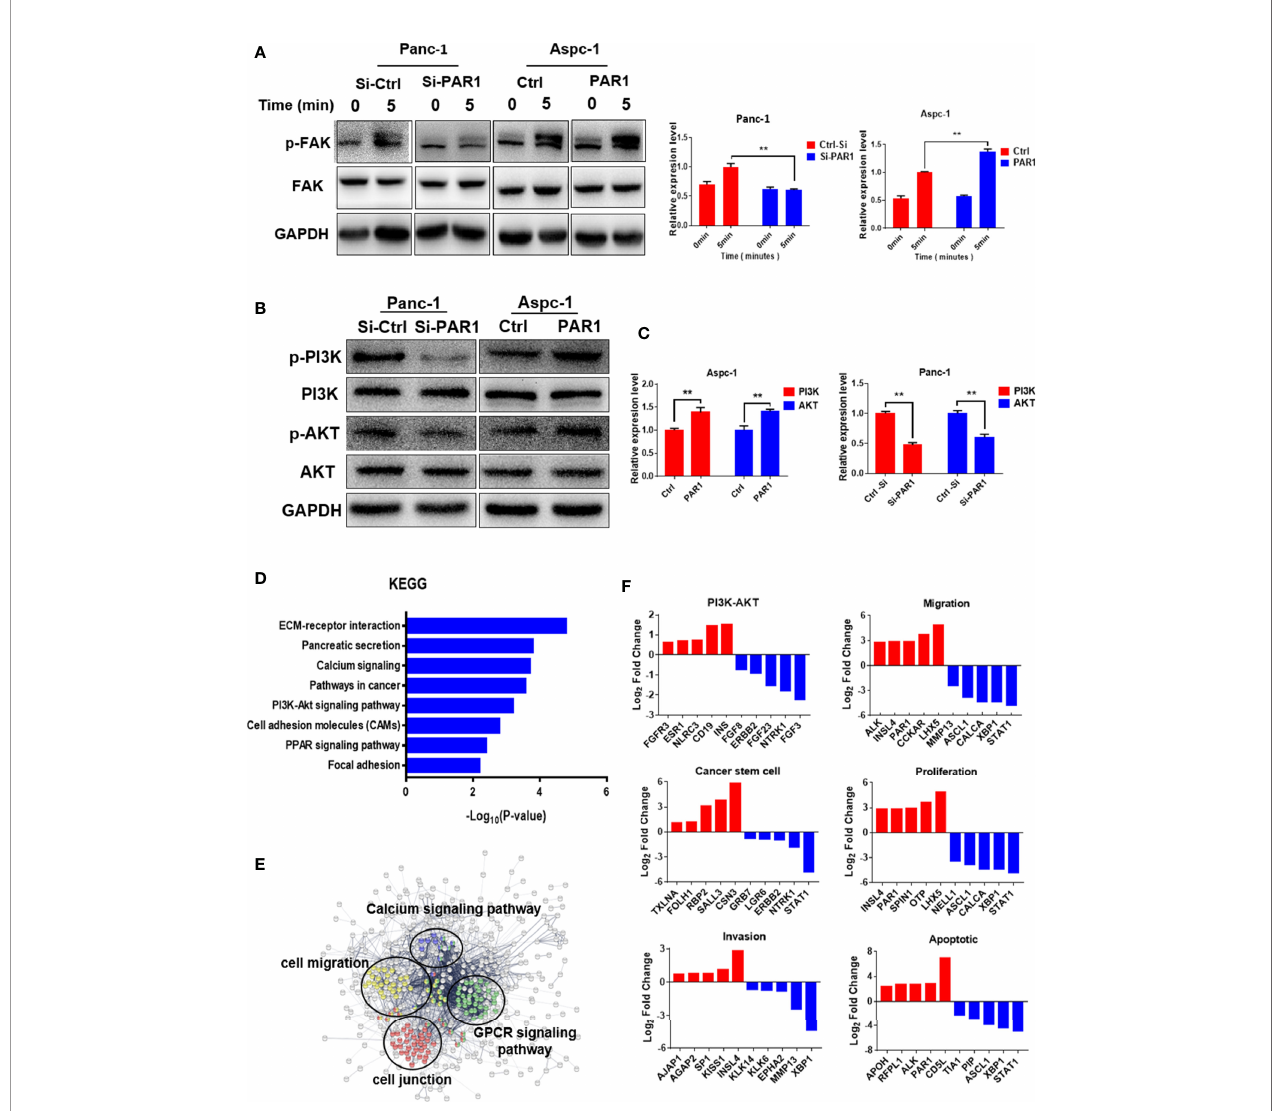
FIGURE 4 | PAR1 can activate theFAK/PI3K/AKTsignaling pathways. (A) PAR1 activation by thrombin can induceFAK autophosphorylation at Y397 inPanc-1 and Aspc- 1 cells. (B) Effect of PAR1 onPI3K andAKT phosphorylation inPanc-1 and Aspc-1 cells. (C) The statistics results of p-PI3K andp-AKTexpression in Panc-1 and Aspc-1 cells. (D) The key pathways affected byPAR1 inpancreaticcancer cells. The genomicdata for patients with pancreaticcancer were clustered byPAR1 expression level, and the differentially expressed genes were analyzed by GO and KEGG. (E) PPIanalysisofproteins involved inthe pathways affected byPAR1. (F) Differentially expressed genes inPI3K/AKT pathway,migration,cancer stem cell, proliferation, invasion, andapoptosispathways. Data are shown as the mean ± SD (** P <